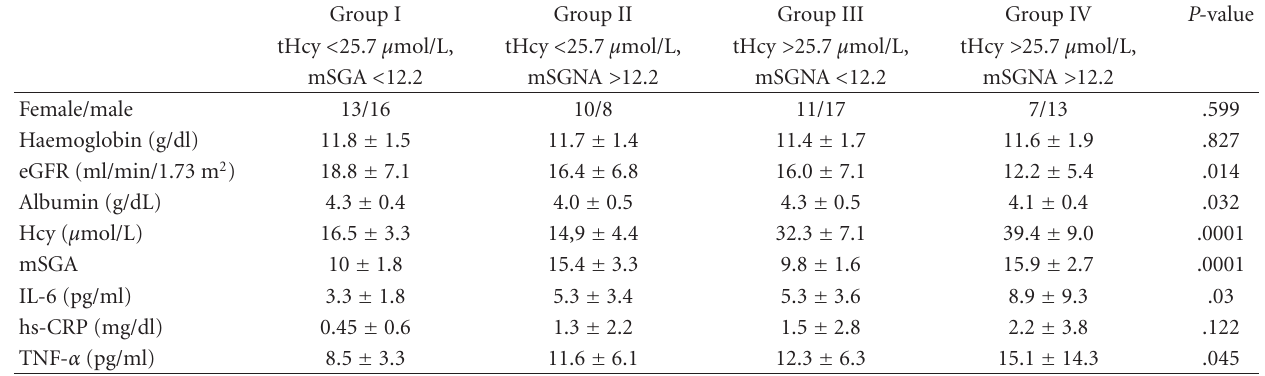
Table 3: Comparison of the di ff erent groups regarding clinical and biochemical